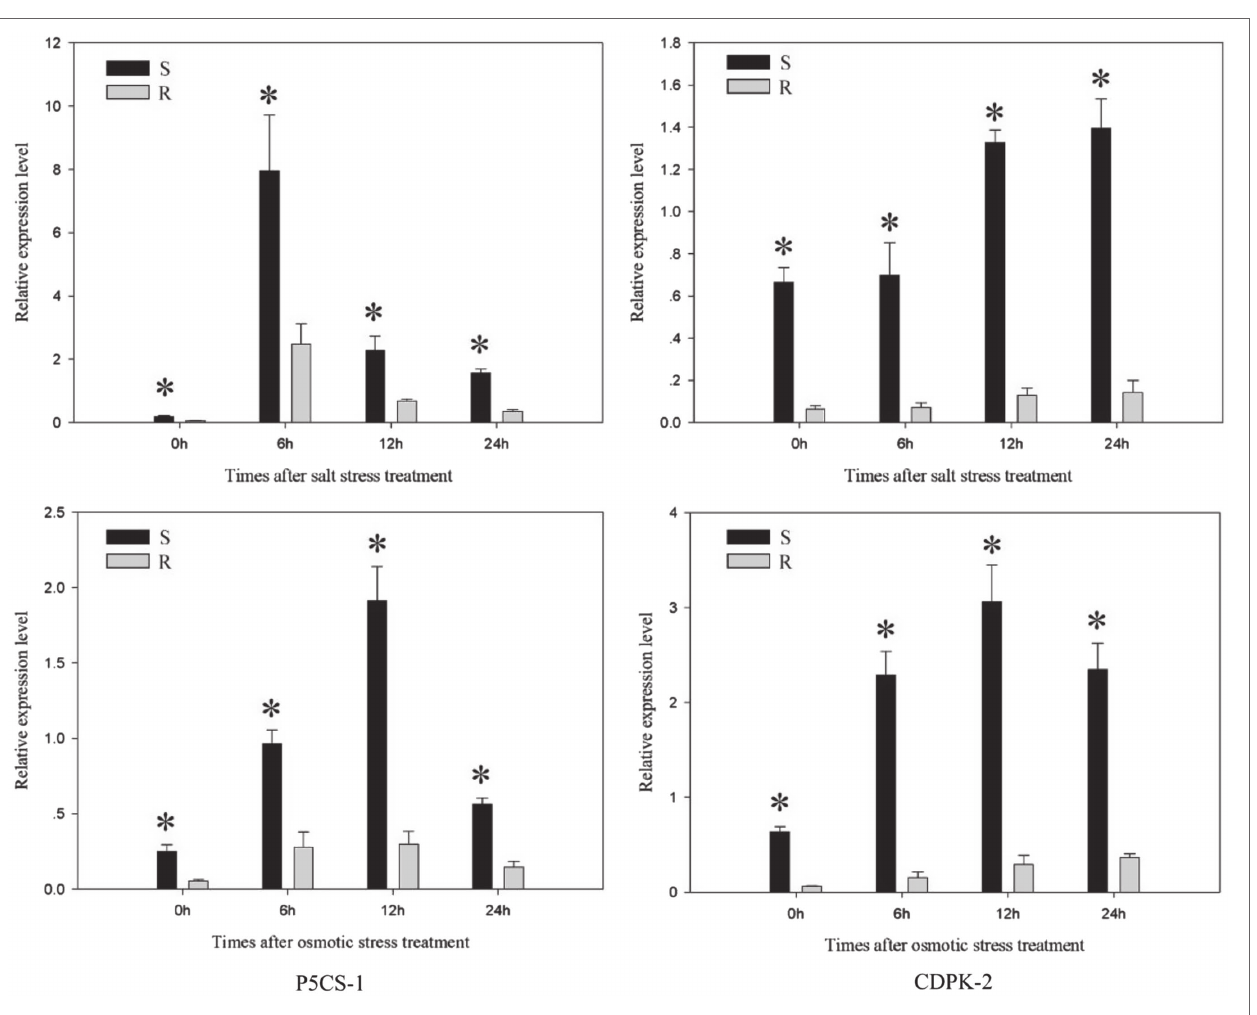
FIGURE 7 | The expression level of P5CS-1 and CDPK-2 gene in the R and S populations after 0, 6, 12, and 24 h treatments of salt stress and osmotic stress, respectively. The standard errors of the means are described by vertical bars. The abbreviations R and S represent for the resistant and sensitive Polypogon fugax populations, respectively. * Indicates significant differences ( p = 0.05) by Turkey’s